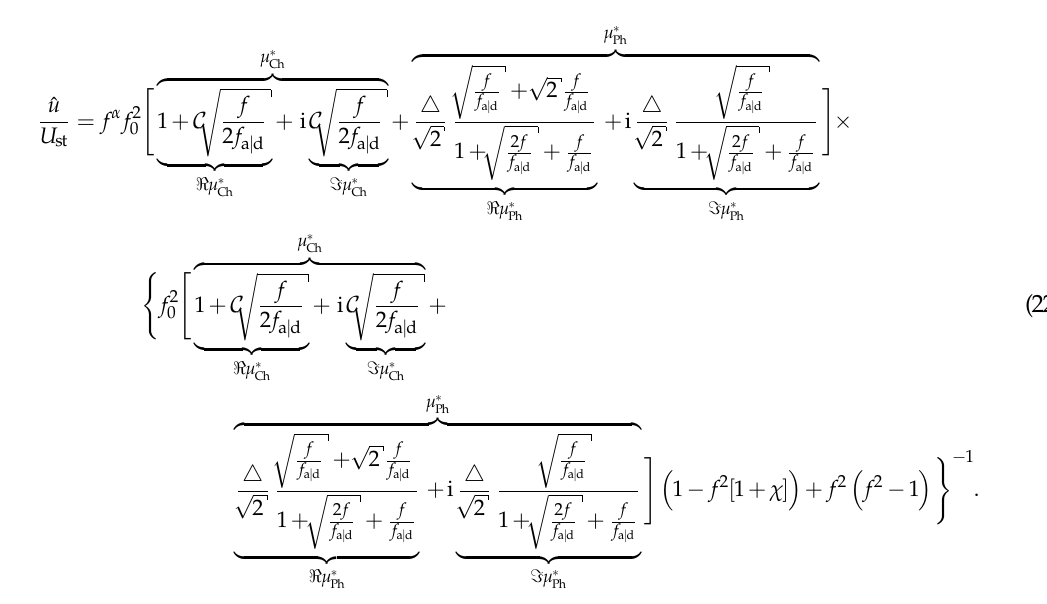
(cid:112) loss factor η Ph = 1/ { 1 + 2 f / ( 1 + (cid:52) ) } —here reading 0.66 and 61% at f = 1, respectively.